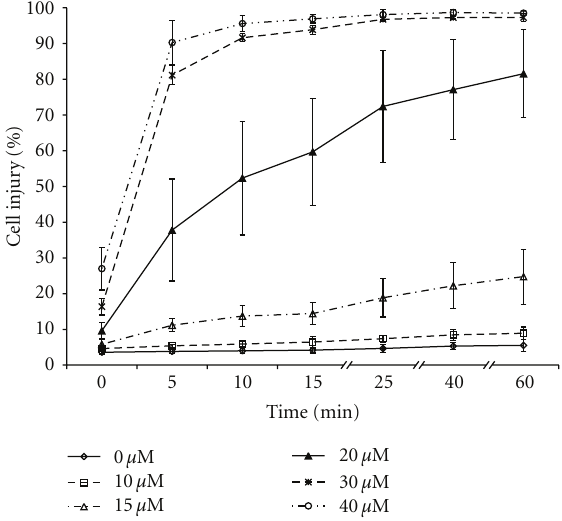
Figure 2: Dose and time dependence of AlCl 3 -induced injury in thymocytes. The cells were treated with a range of concentrations of AlCl 3 (0–40 µ M) at various time points. Thymocytes were considered to be damaged when the level of fluorescence intensity of PI in the cells was higher than the level in untreated cells. Values are mean ± SD obtained from six independent measurements (based on Student’s paired t -test). The concentration curves are all statistically significantly di ff erent at the P < . 05 level by ANOVA analysis. There are no significant changes with time between 25, 40, and 60 minutes, nor between 10 and 15 minutes, but all other time di ff erences are significant.